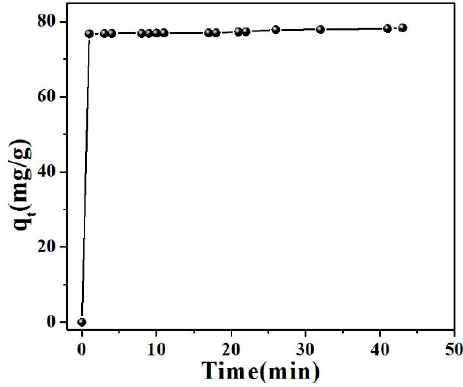
Figure 4. The kinetic data for Rhodamine B by magnetic porous carbon.